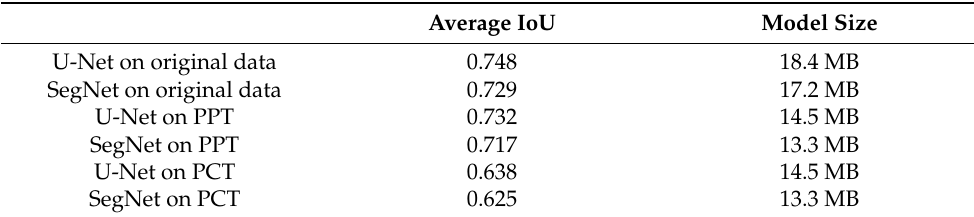
Table 2. Results on validation dataset of PPT and PCT images.